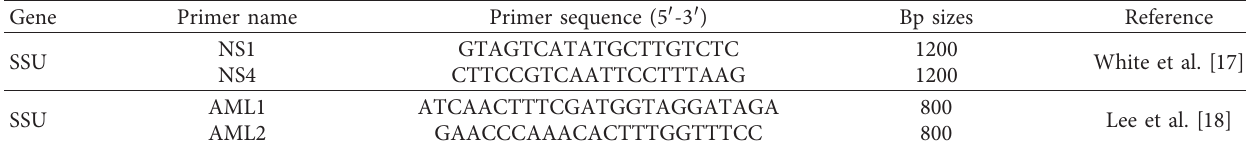
Table 1: Primer sequences used in nested PCR amplification of